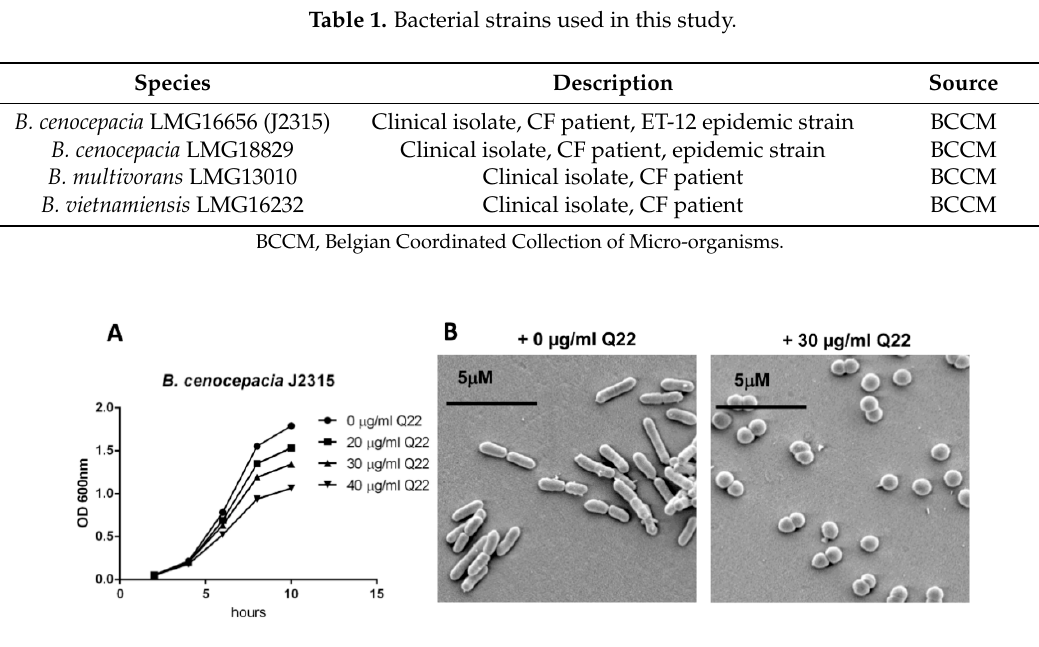
Figure 1. Growth and morphological changes induced by Q22 treatment. ( A ) Growth of B. cenocepacia J2315 in the absence or presence of increasing concentrations of Q22 (0, 20, 30, 40 μ g/mL); ( B ) scanning electron microscope images of B. cenocepacia J2315, untreated and after treatment with 30 μ g/mL